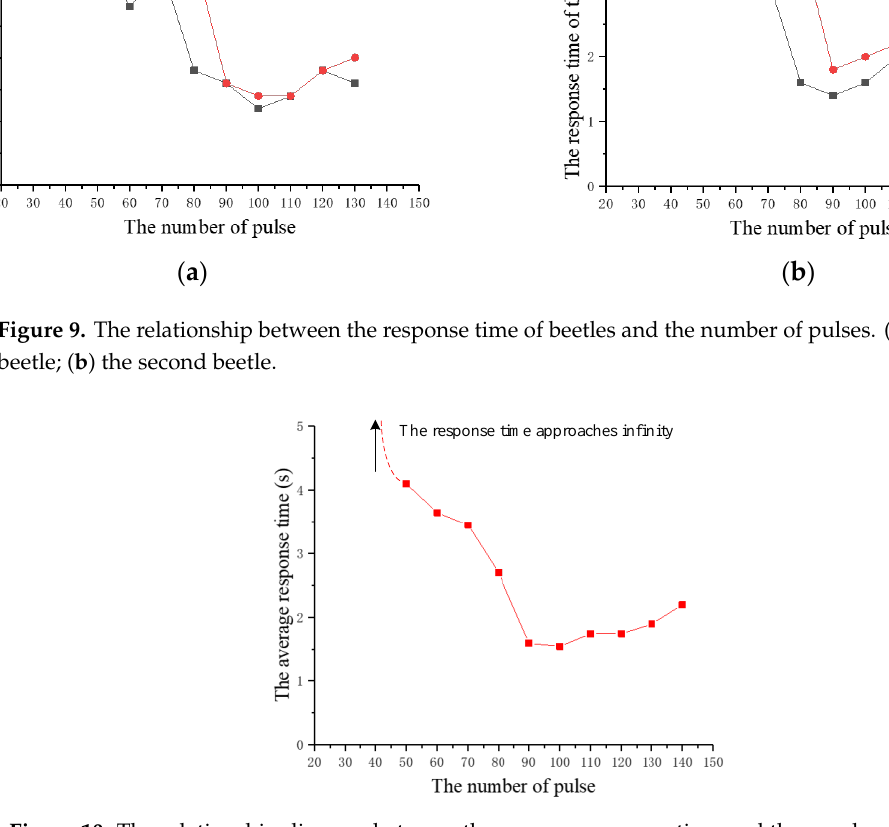
Figure 10. The relationship diagram between the average response time and the number of pulses.